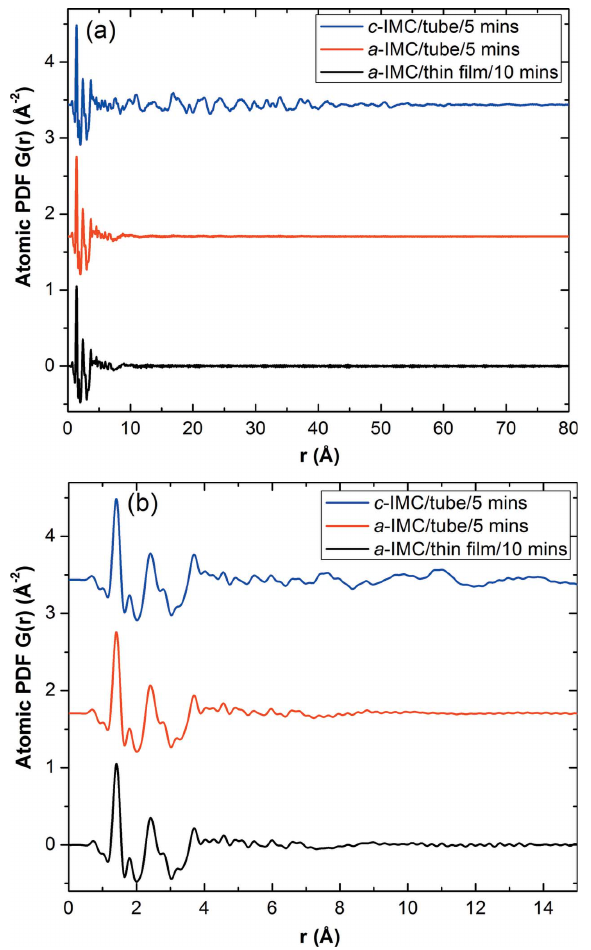
Figure 4 PDFs of crystalline and amorphous IMC plotted over r ranges of ( a ) up to 80 A˚ and ( b ) up to 20 A˚ . The measured crystalline PDF is also plotted as a